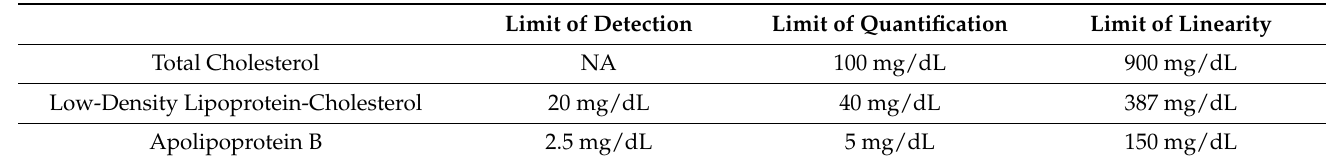
Table 2. Limits of detection and quantification, and linearity of total cholesterol, low-density lipoprotein-cholesterol, and apolipoprotein B in dried blood spots.